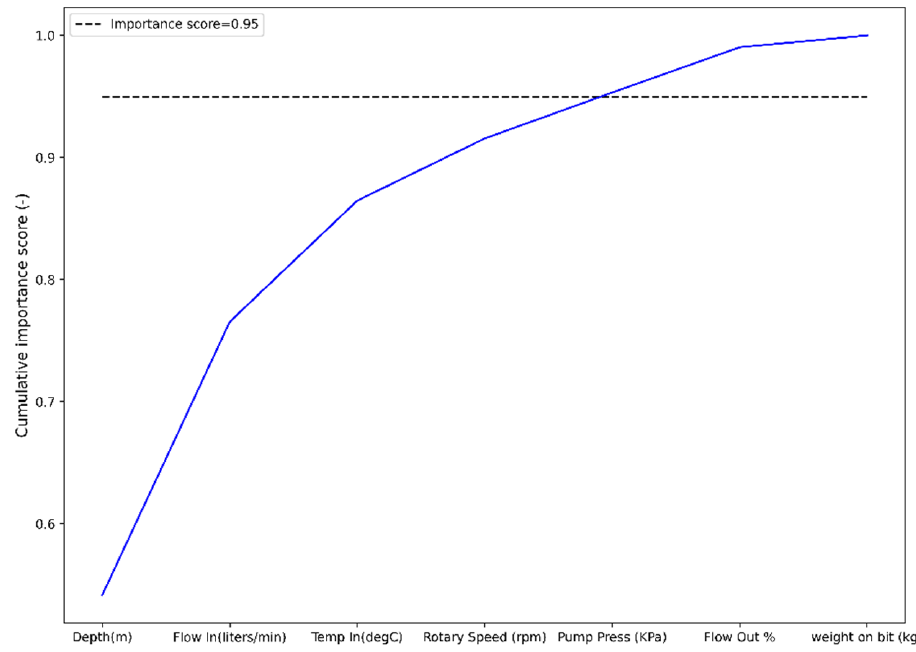
Figure 13. Cumulative feature importance with a 0.95 threshold line .